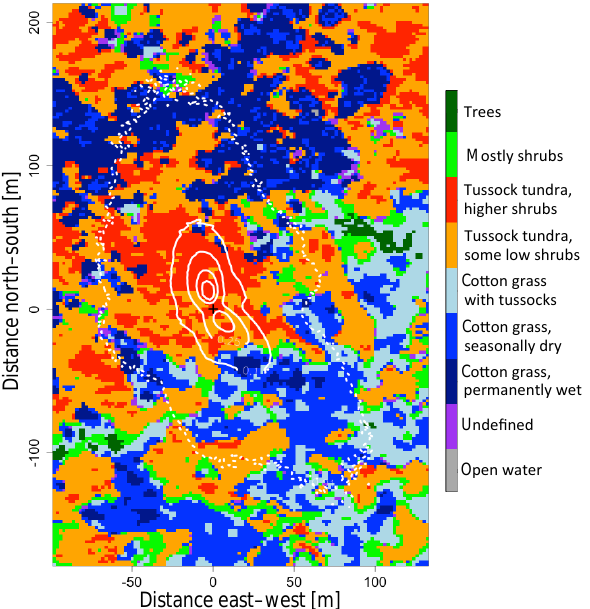
Figure A1. Accumulated source-weight function for the EC tower in a control area within the Chersky study site, based on data from the growing season (mid-June–mid-September) in 2014. Solid white isolines indicate the 80, 60, 40, and 20% levels; the dashed line is the 10% level. Background colors indicate aggregated land cover classes based on WorldView-2